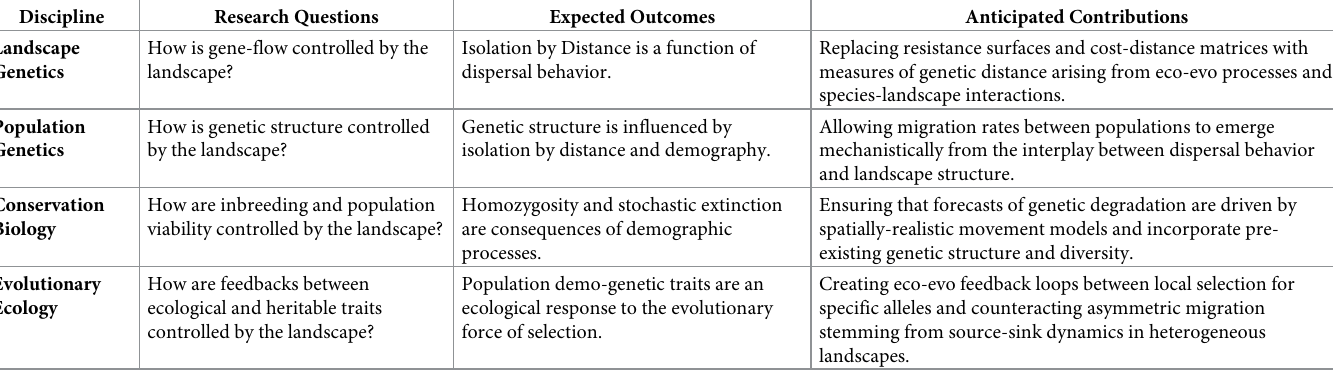
Table 1. How spatially structured eco-evolutionary models might contribute to four focal